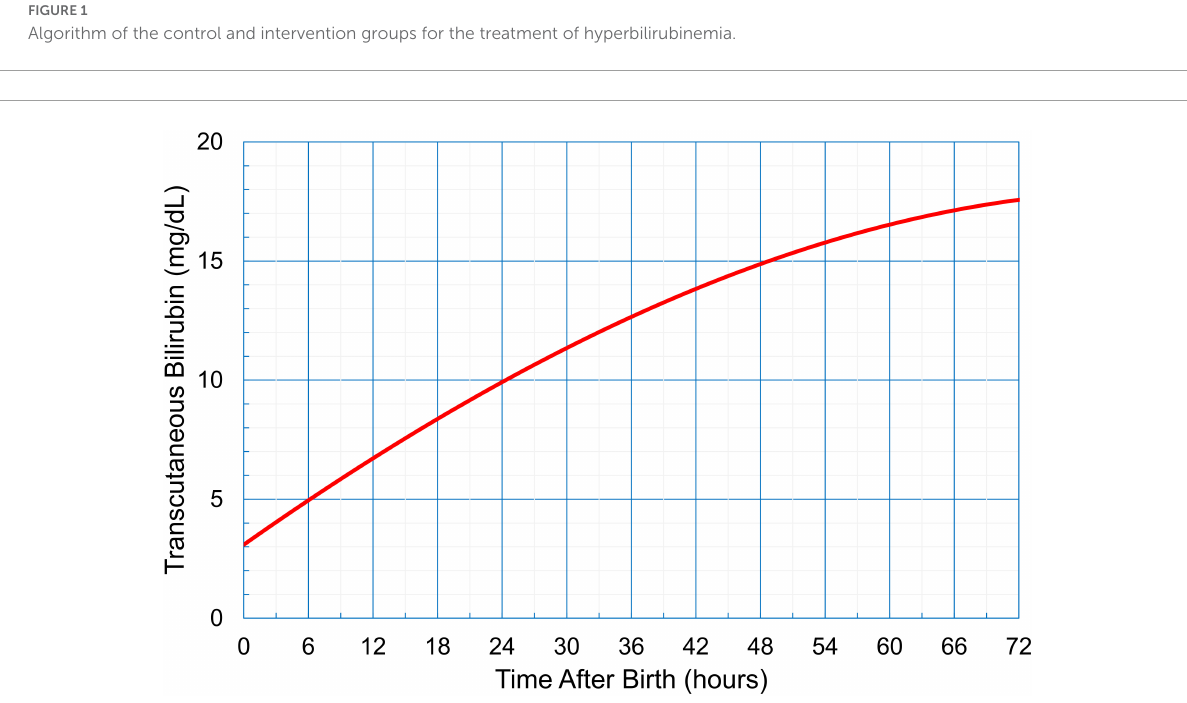
FIGURE2 An hour-specific transcutaneous bilirubin nomogram for neonates in Myanmar (gestational age ≥ 35 weeks, birthweight > 2,000 g). This nomogram card was distributed to medical professionals for detecting neonatal hyperbilirubinemia.